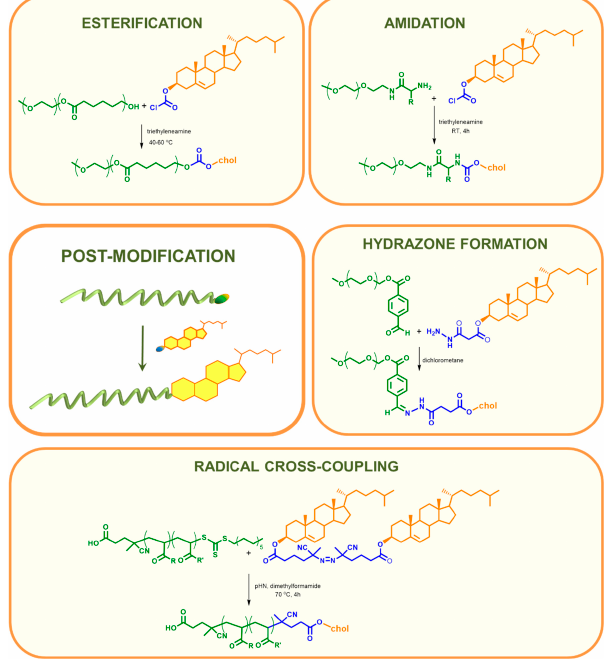
Figure 4. Post-modification reactions used to introduce cholesteryl moieties at the end of the polymeric chain [27,58,69,74].